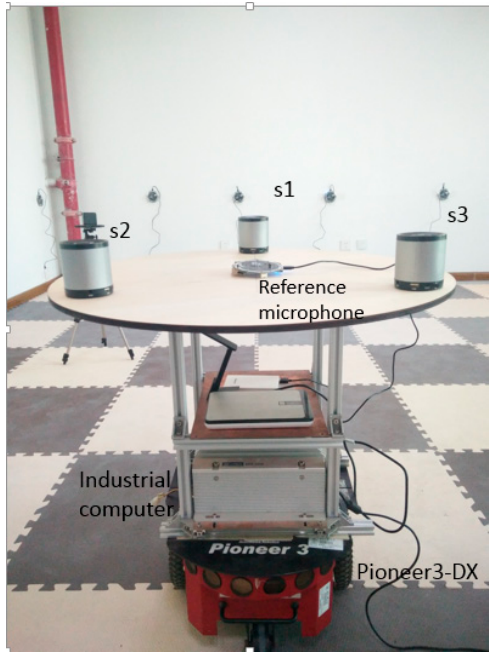
Figure 12. Positional relationship of the sound source array, reference microphone, and mobile robot.